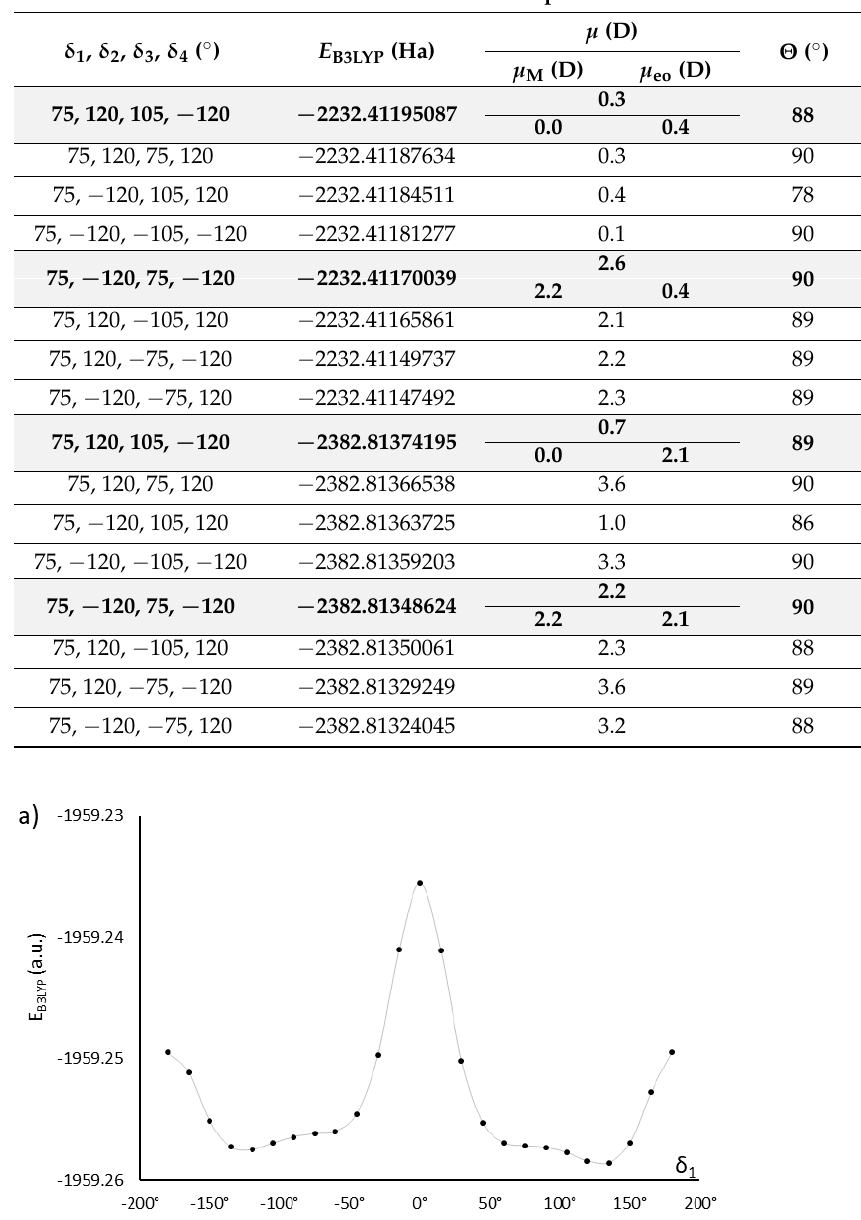
noteworthy that the dipole moment of AU12 β conformer is much larger than in AU12 α . In this molecule, orientation of the polar epoxy chains (whose dipole moments are comparable with the mesogen) also has large impact on the value of total dipole moment (Table 2). Table 1. Results of geometry optimization for M22 and MU22. The angles δ i describe the initial conformation. E is the B3LYP energy after optimization. Values of the dipole moment: µ — total, µ M —mesogen, µ eo— epoxy chain. Θ is the angle between the total dipole moment and the principal molecular axis. The two chosen conformations for each molecule are highlighted. Initial Conformation Optimized Structure